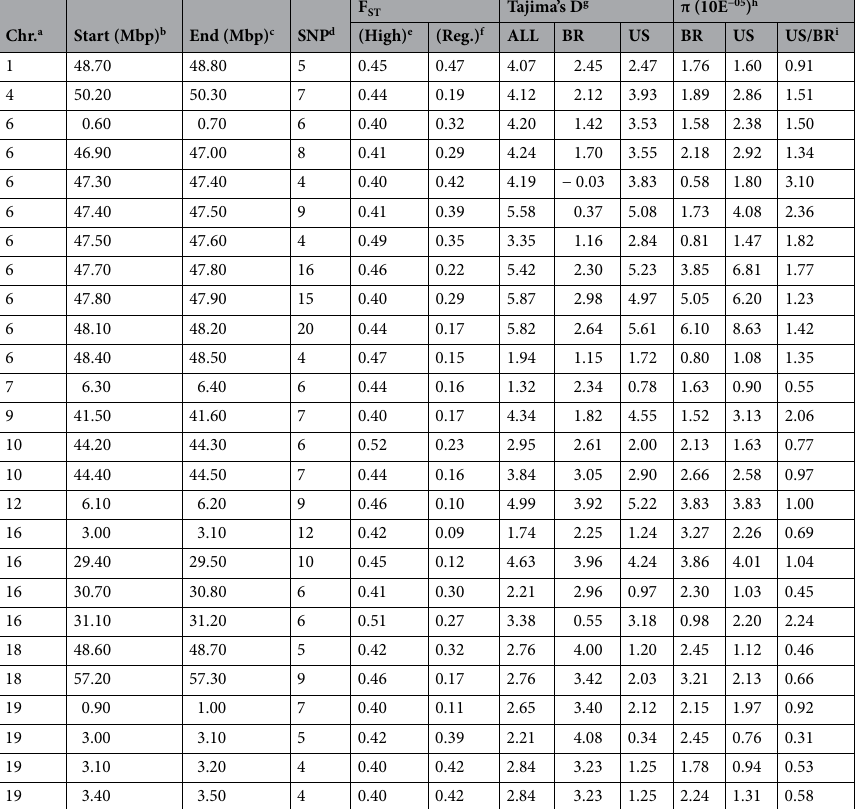
Table 1. Summary of the genomic regions with high F ST values between Brazilian and US germplasms. a Soybean chromosome. b Start position of the genomic region with high F c End position of the ST values. genomic region with high F ST values. d total number of SNPs observed in this interval. e The highest F ST value observed in a SNP of this interval. f The genomic region average F ST . g Tajima’s D coefficient for all (ALL), Brazilian (BR), and United States (US) germplasms. h Nucleotide diversity values for all (ALL), Brazilian (BR), and United States (US) germplasms. i nucleotide diversity ratio between the